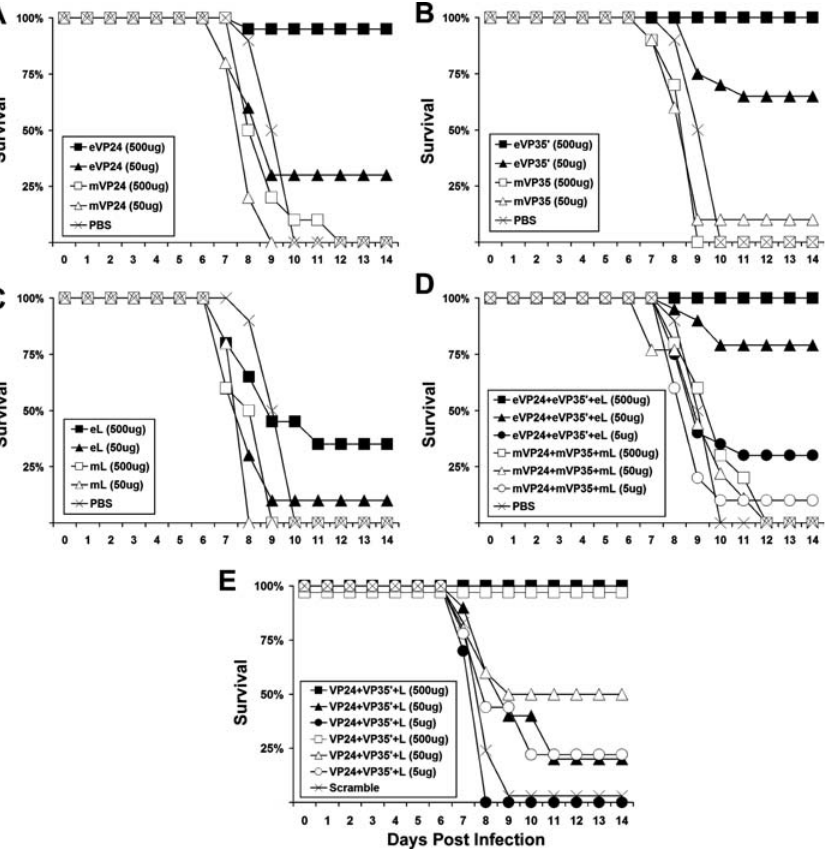
Figure 2. Ebola-Specific PMOs Protect Mice from Lethal Ebola Virus Infection (A–C) Survival of mice ( n ¼ 10) pretreated at 4 h and 24 h before EBOV infection with 500 (square) or 50 (triangle) l g doses of PMOs targeting EBOV- (filled) or MARV-specific (unfilled) VP24 (A), VP35 (B), L (C), or with PBS ( 3 ). (D) Survival of mice ( n ¼ 10) pretreated at 24 h and 4 h before EBOV infection with 500 l g (square), 50 l g (triangle), or 5 l g (circle) doses of a combination of the EBOV- (filled) or MARV-specific (unfilled) VP24, VP35, and L PMOs or PBS ( 3 ). (E) Survival of mice ( n ¼ 10) treated 4 h before (unfilled) or 24 h after (filled) EBOV infection with 500 l g (square), 50 l g (triangle), or 5 l g (circle) of the combination of EBOV-specific PMOs or an unrelated sequence ( 3 ). All the animals in these studies were monitored for at least 28 d for illness, and there were no differences observed in survival within any of the groups between 14 d and 28 d. DOI: